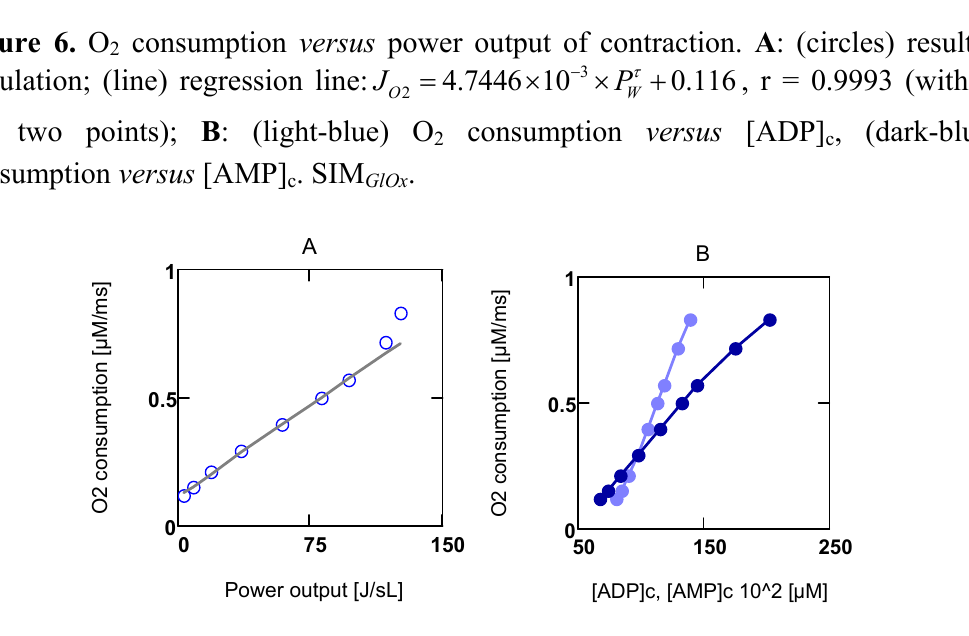
, (dark-blue) O c 2